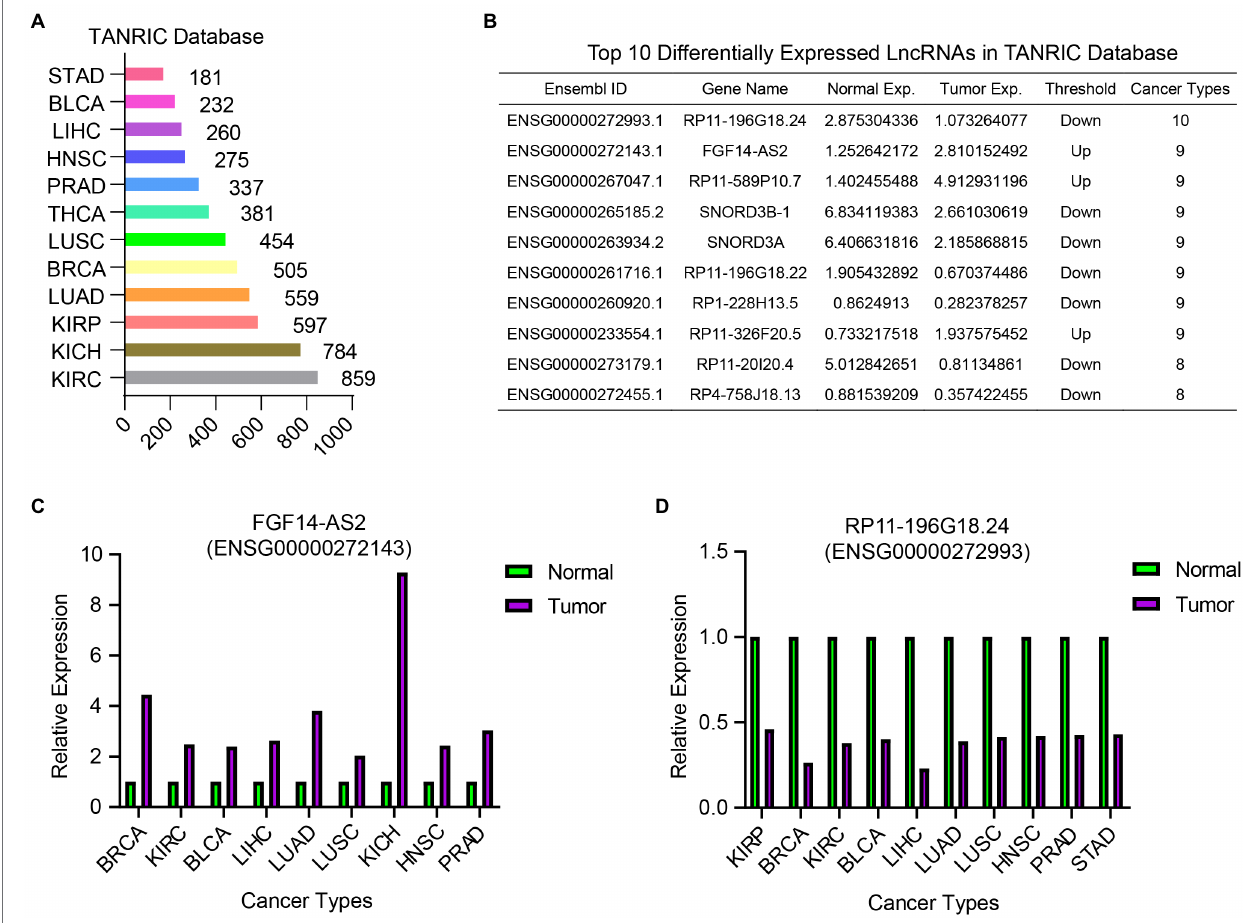
FIGURE 2 | Differentially expressed LncRNAs analysis in 12 TCGA cancer types between tumor samples and normal samples. (A) The number of identified DELncs in each cancer type in TANRIC database. (B) A list of top 10 common DELncs in 12 cancer types. (C) The relative expression of FGF14-AS2 in BRCA, KIRC, BLCA, LIHC, LUAD, LUSC, KICH, HNSC, and PRAD samples compared with normal samples. (D) The relative expression of RP11-196G18.24 in KIRP, BRCA, KIRC, BLCA, LIHC, LUAD, LUSC, HNSC, PRAD, and STAD samples compared with normal